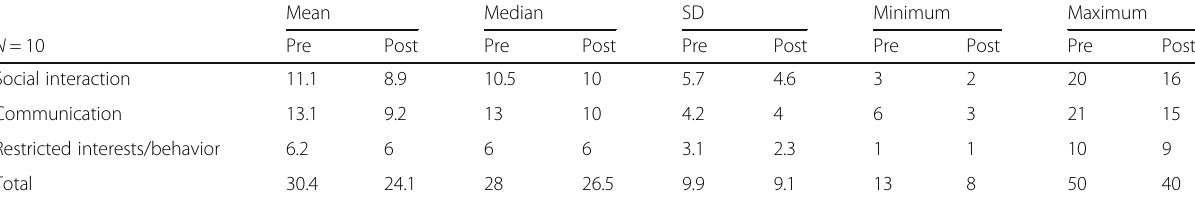
Table 2 Measures of central tendency in ADI-R of the ten subjects in pretest and posttest